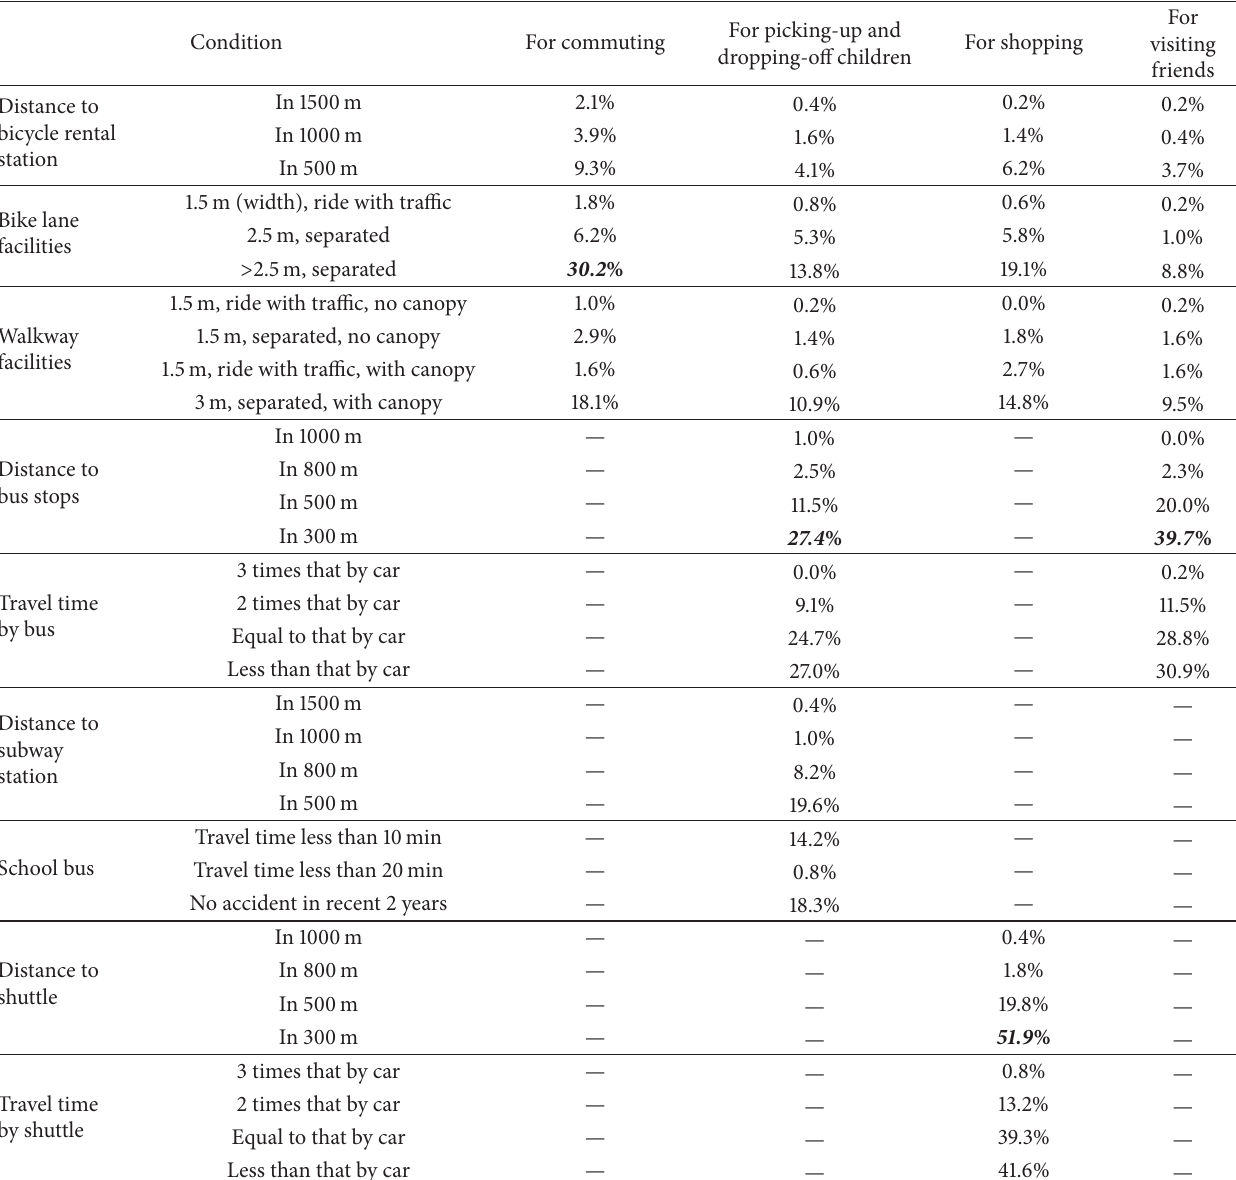
Table 3: Stated willingness of mode shift for various travel purposes. Condition For commuting